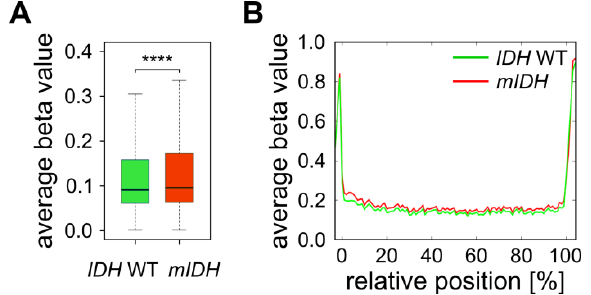
FIGURE 4: TET-dependent DNA methylation canyons are not specifically affected by mIDH -associated hypermethylation in AML. (A) Average methylation ratios of canyon-associated probes in mIDH and IDH WT patients. The difference between the two groups was highly significant (**** P <0.0001). (B) Superposition of all size-normalized canyons depicting aver- age methylation levels of these features in the two patient